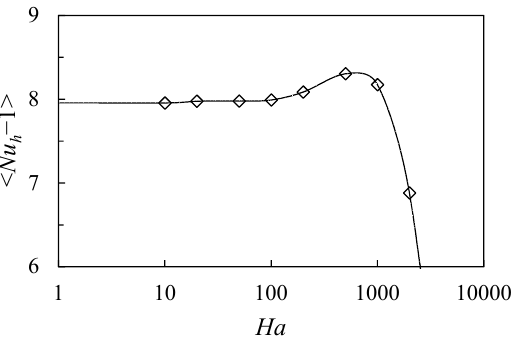
Figure 15. Enlarged diagram of time-mean average Nusselt number versus Hartmann number at κ = 0.5 and Ra = 10 7 .